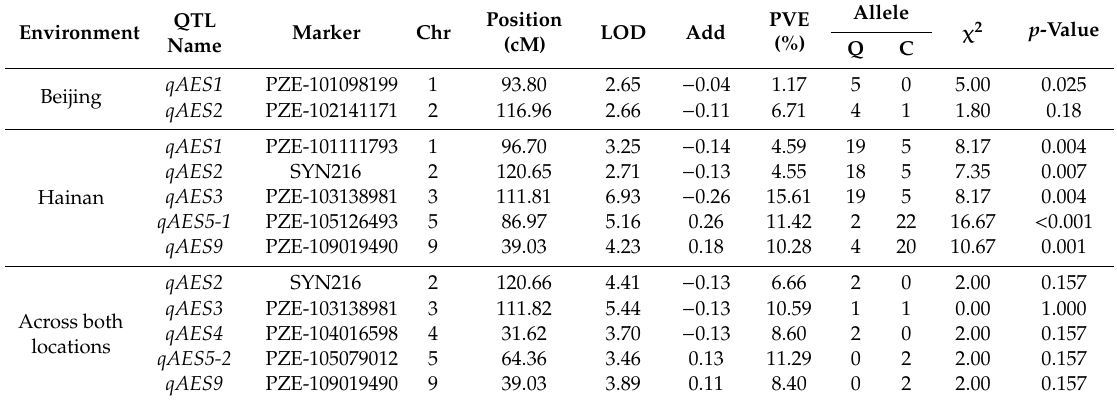
Across both locations